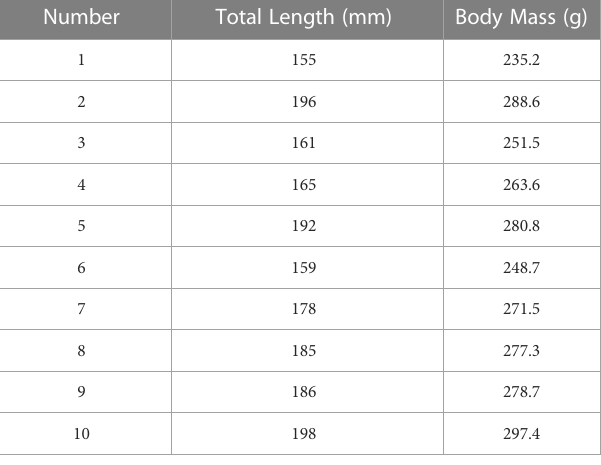
TABLE 1 Data of total length and body mass of wild yellow groupers in the